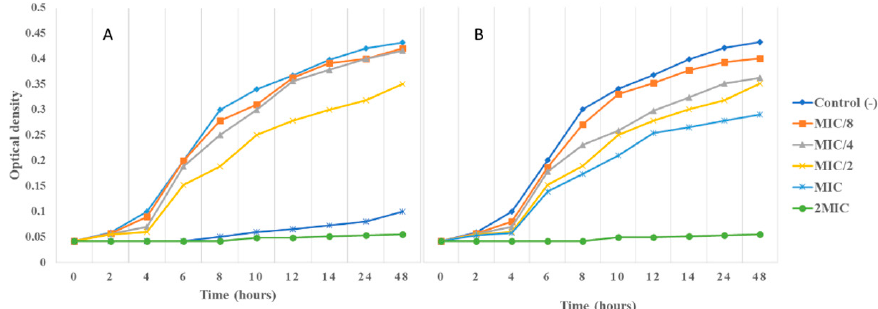
Figure 9. The action of optimized ethanolic bark extract of Enantia chlorantha ( A ) and AgNPs ( B ) on E. coli ATCC 25922 growth kinetic. MIC = minimum inhibitory concentration.